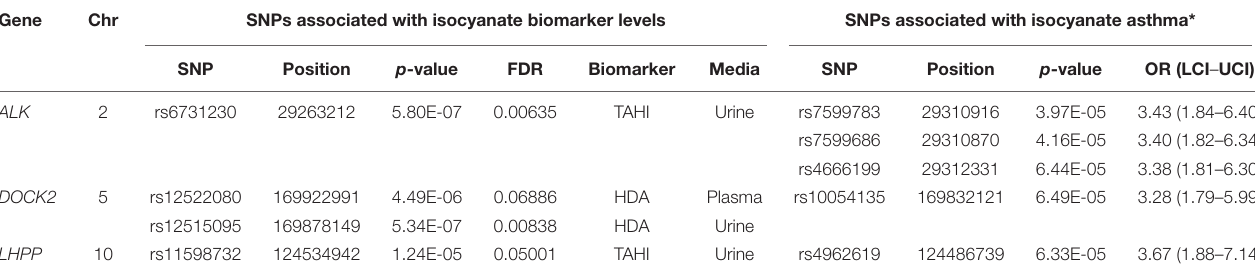
TABLE 2 | Three candidate genes contained four single-nucleotide polymorphisms (SNPs) [minor allele frequency (MAF) > 0.05] that were associated with exposure-adjusted biomarker levels [false discovery rate (FDR) < 0.10]. Gene Chr SNPs associated with isocyanate biomarker levels SNPs associated with isocyanate